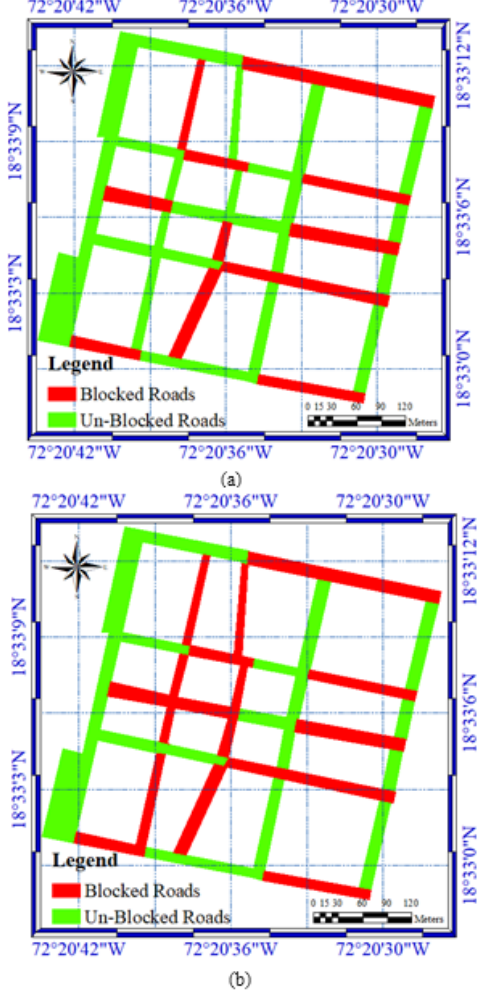
Figure 7. The result of DRD for the test area using the proposed framework. (a) The resulted map using the MLP- CNN classification; (b) Ground